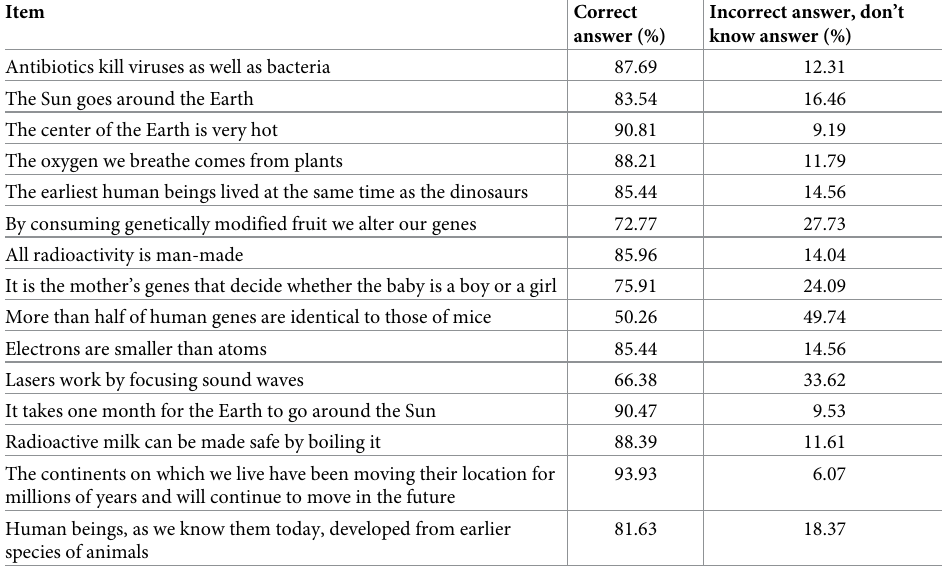
Table 4. Descriptive statistics for the science literacy